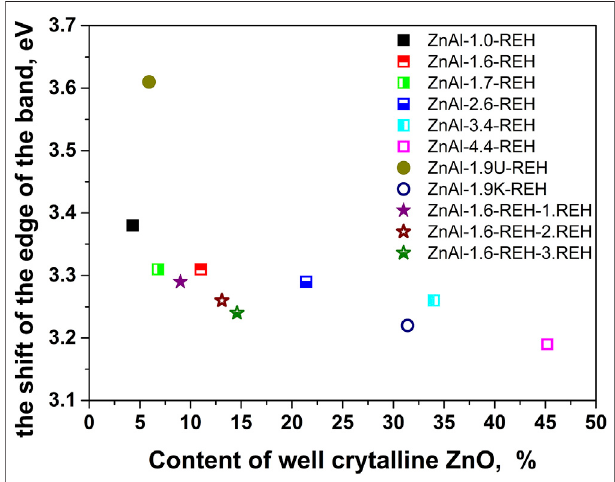
FIGURE 4 | The dependence of the shift of the edge of band on the contentofwellcrystallineZnOphasedetermined byphaseanalysisfromXRD.